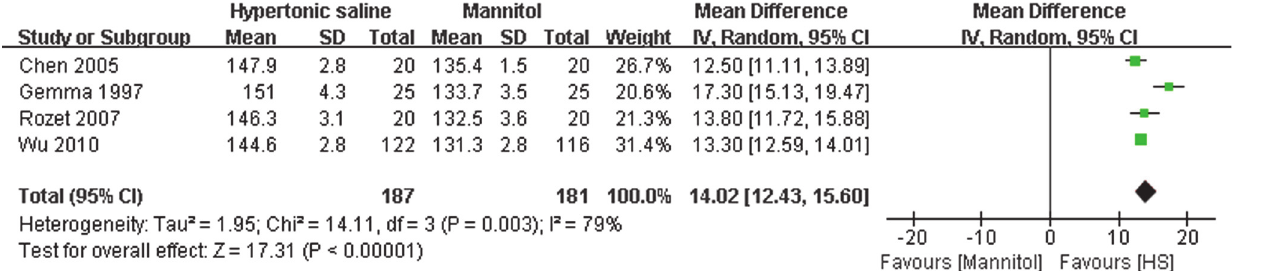
PLOS ONE | DOI:10.1371/journal.pone.0117314 January 30,